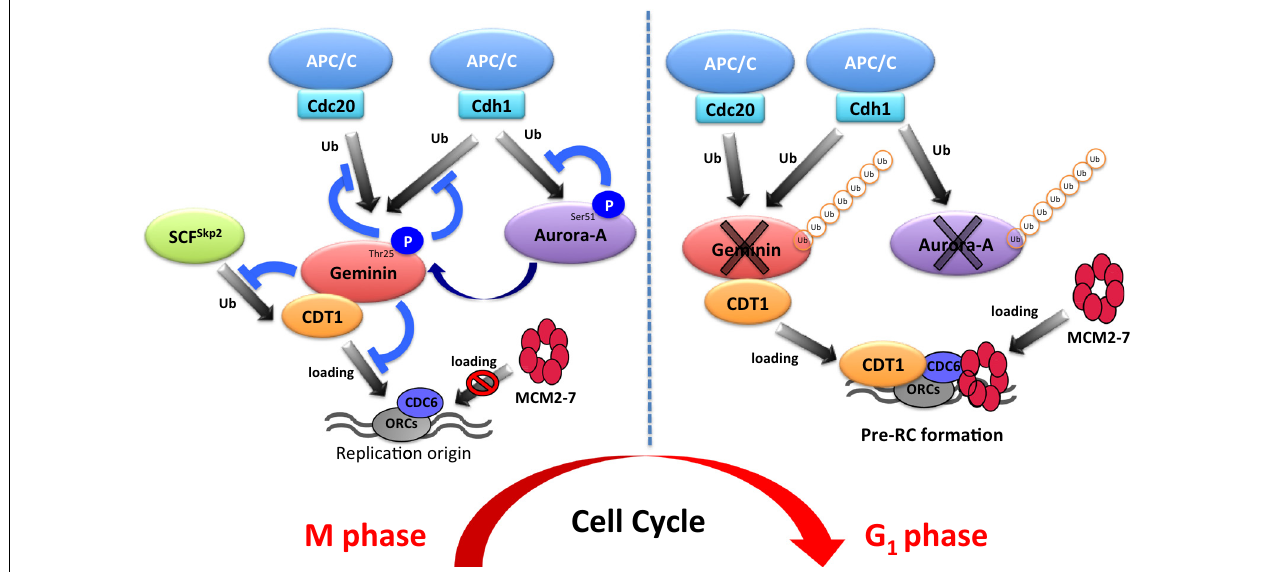
FIGURE 2 | Schematic model of DNA replication via the aurora-A–geminin–CDT1 axis .